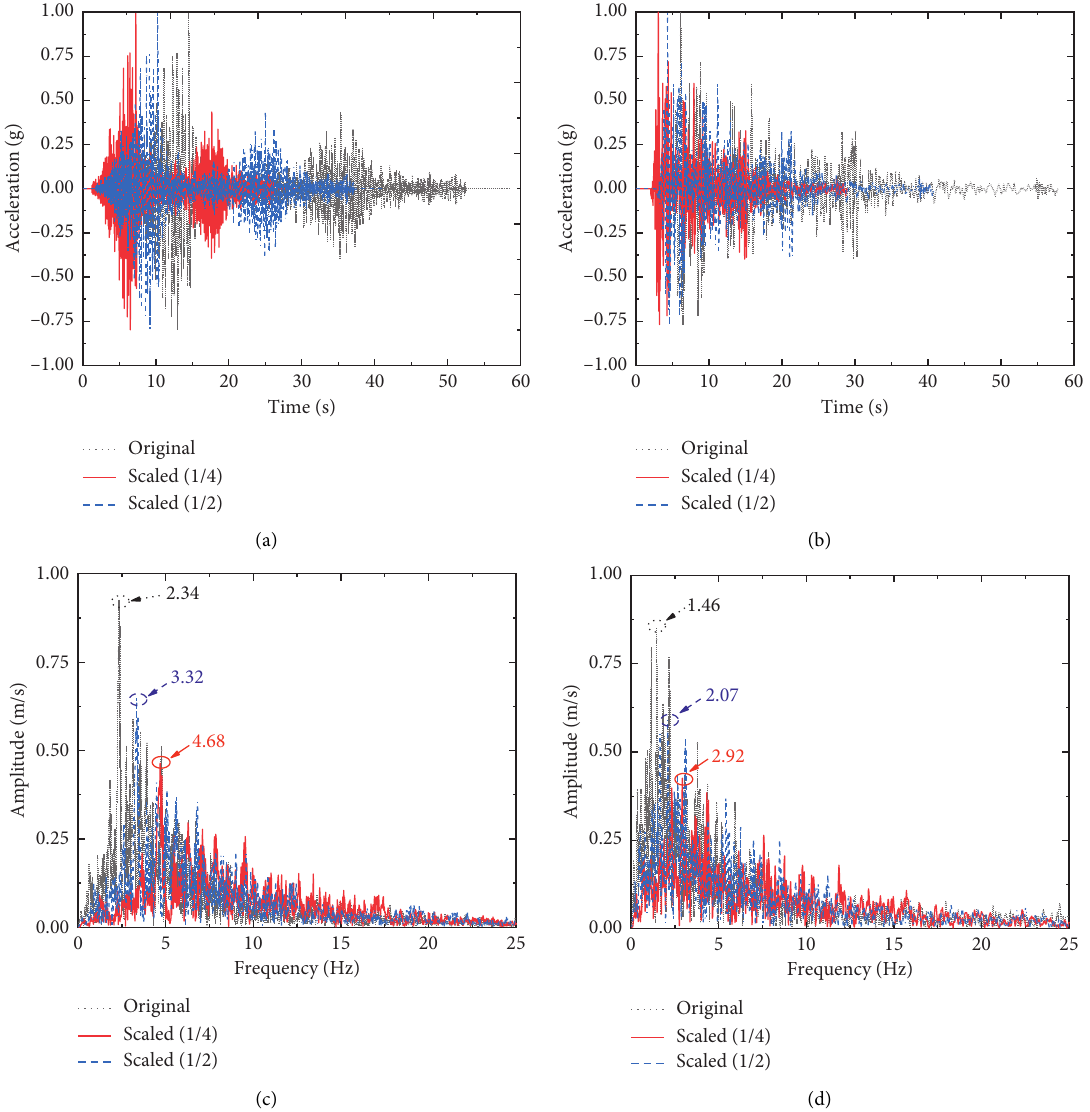
Figure 3: Input motions: (a) WL acceleration time history, (b) EL acceleration time history, (c) WL Fourier spectra, and (d) EL Fourier